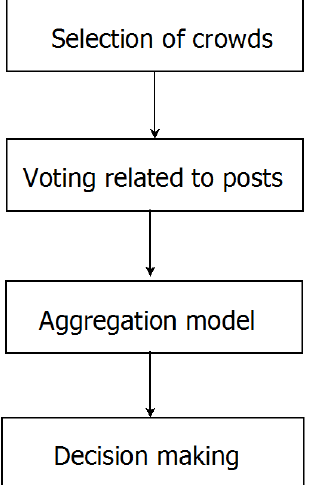
Figure 1. Research